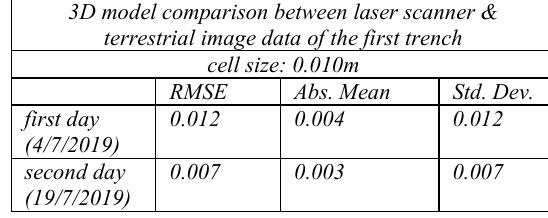
Table 8 . 3D model comparison between laser scanner and terrestrial image data of the first and the second day of the documentation of the excavation activity of the first trench.